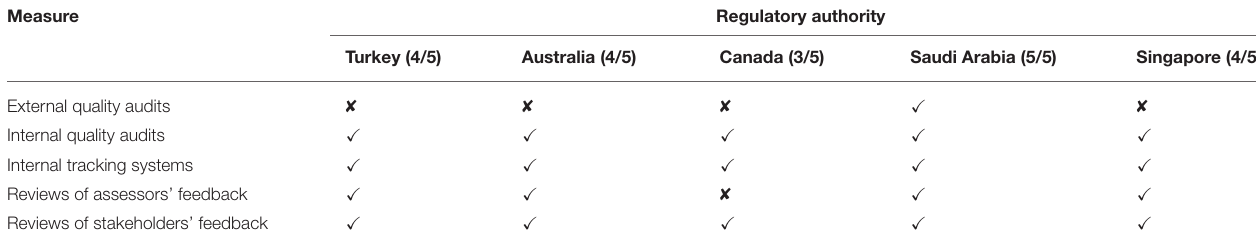
TABLE 4 | Continuous improvement initiatives in the five